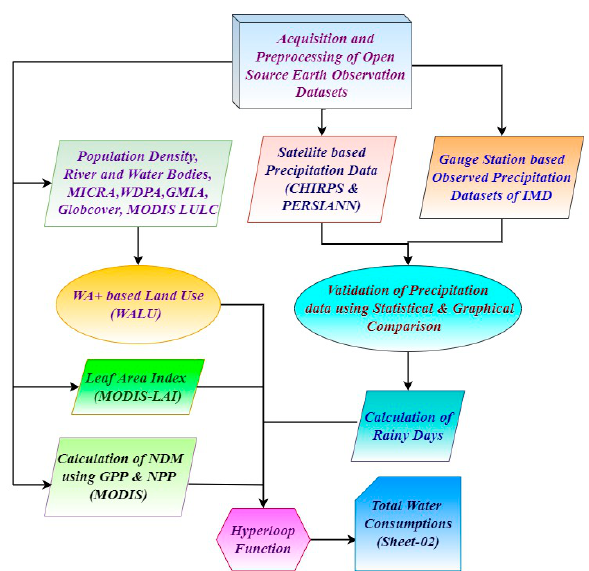
Figure A1. Diagram of methodology describes the steps opted for estimating total water consumption in the BRB.